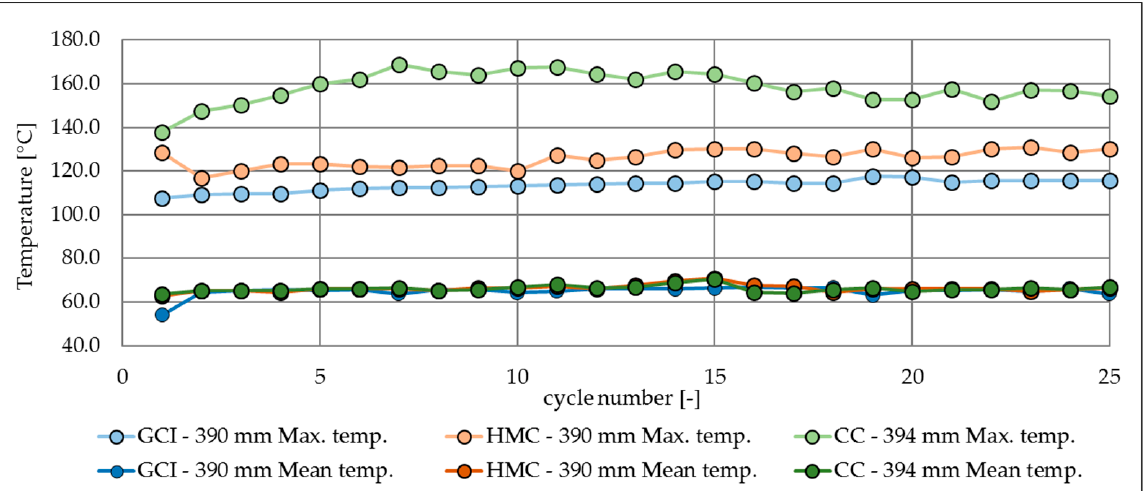
Figure 13. Course of the average and maximum temperatures per cycle over the bedding process (Vehicle 1)—WLTP brake cycle trip #10.